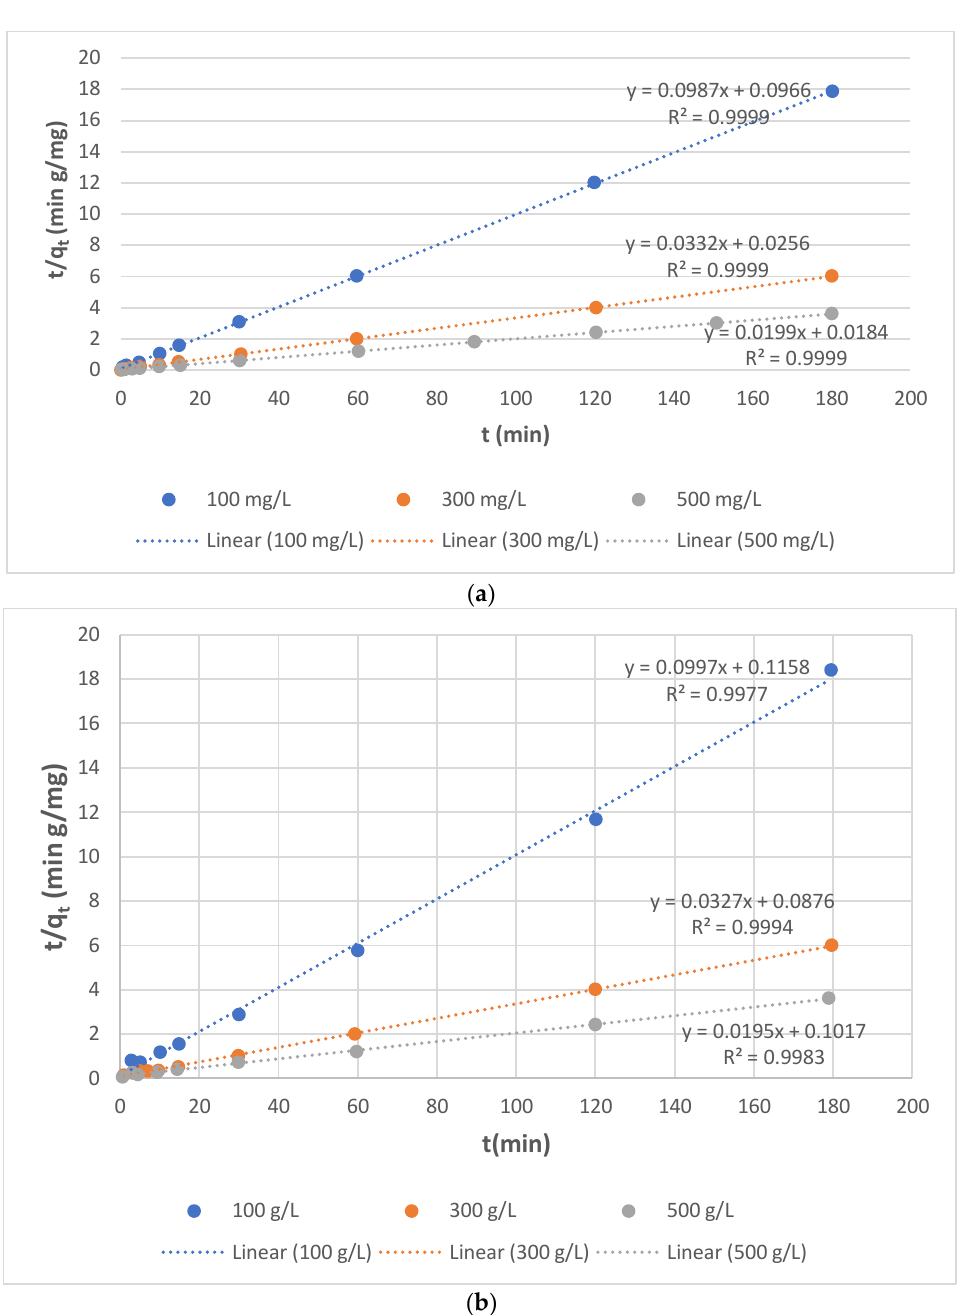
Figure 8. t/ 𝑞 𝑡 vs. t dependencies determined from the linear form of the PSO model in ( a ) Yellow GL-SBR and ( b ) Yellow GL-WBR systems.